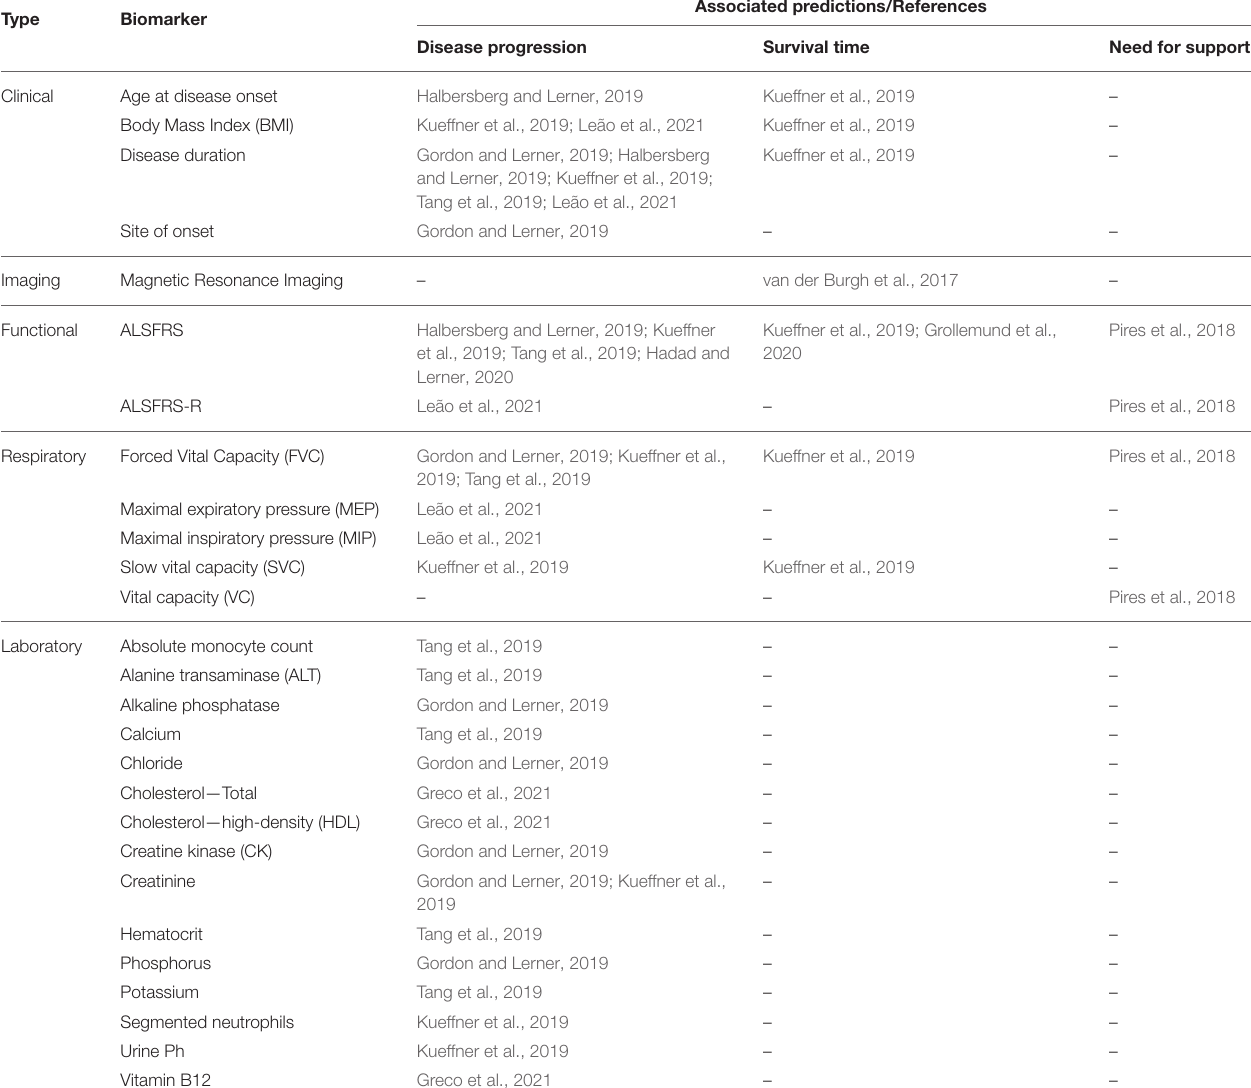
TABLE 9 | Most relevant biomarkers identified, associated predictions, and